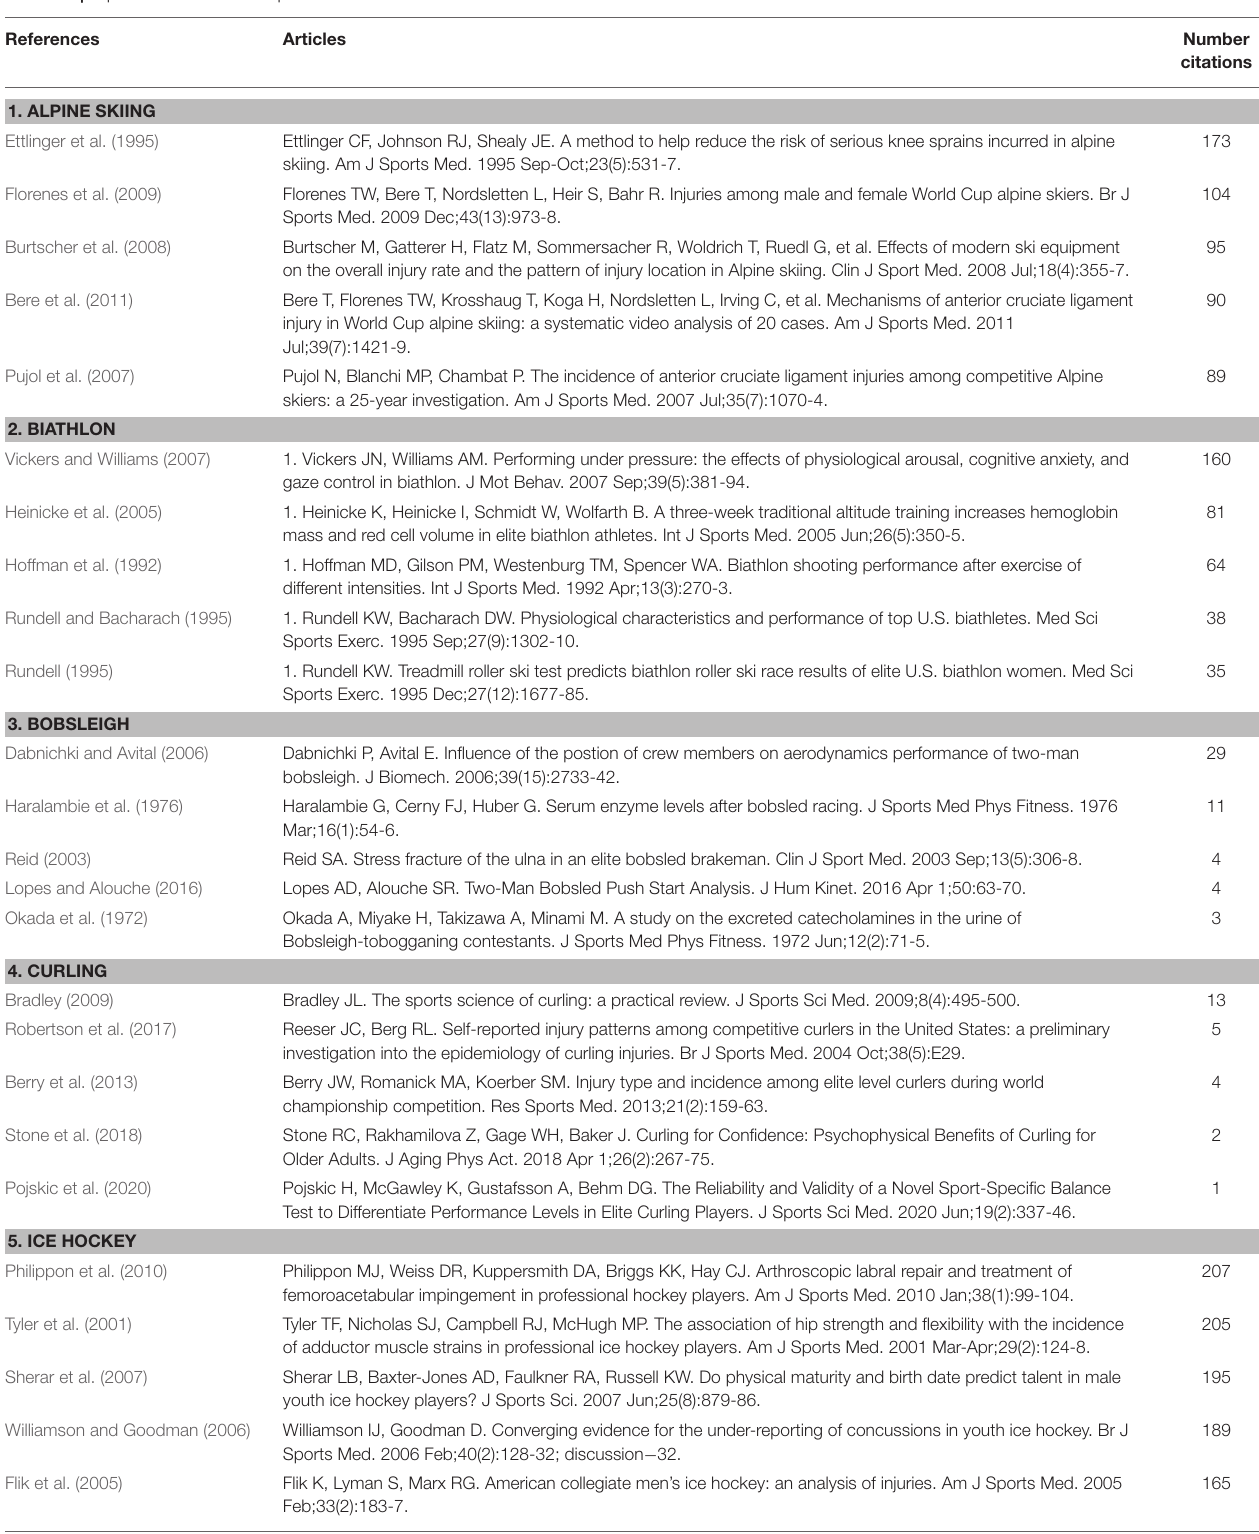
TABLE 5 | Top-5 articles on winter